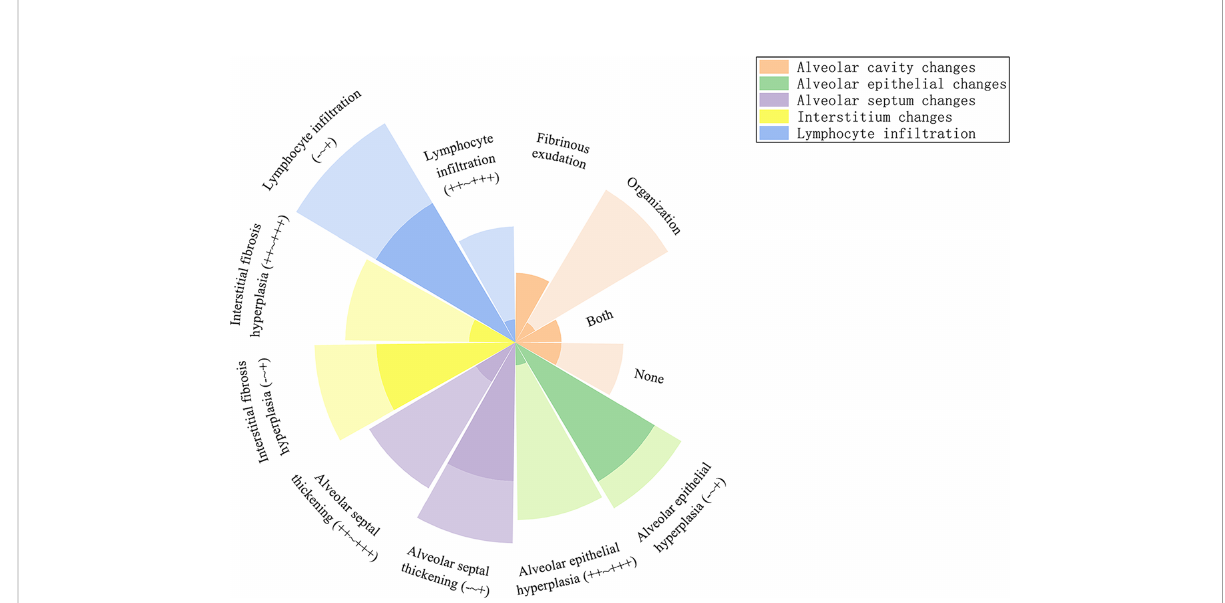
FIGURE 4 Radial stacked column chart of different histologic features in the acute and subacute phases. The dark part represents the proportion of the number of people with this characteristic to the total population in the acute phase, and the light part represents the subacute phase.